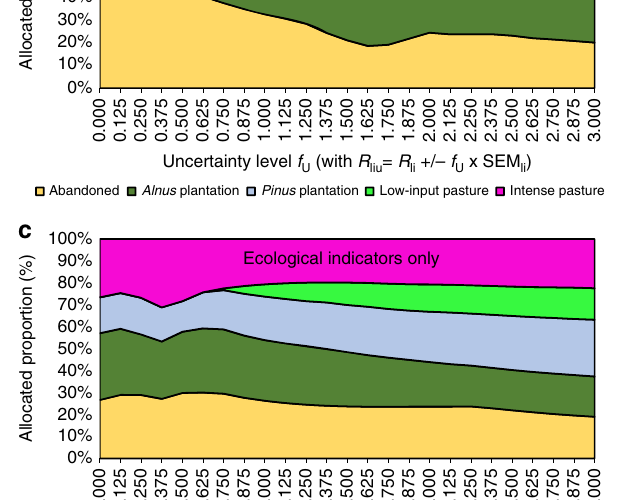
to land-cover types. In conclusion, while the high landscape diversity is required to improve multiple uncorrelated ecosystem services, high landscape diversity may also be desirable to achieve statistical averaging effects to reduce uncertainty.